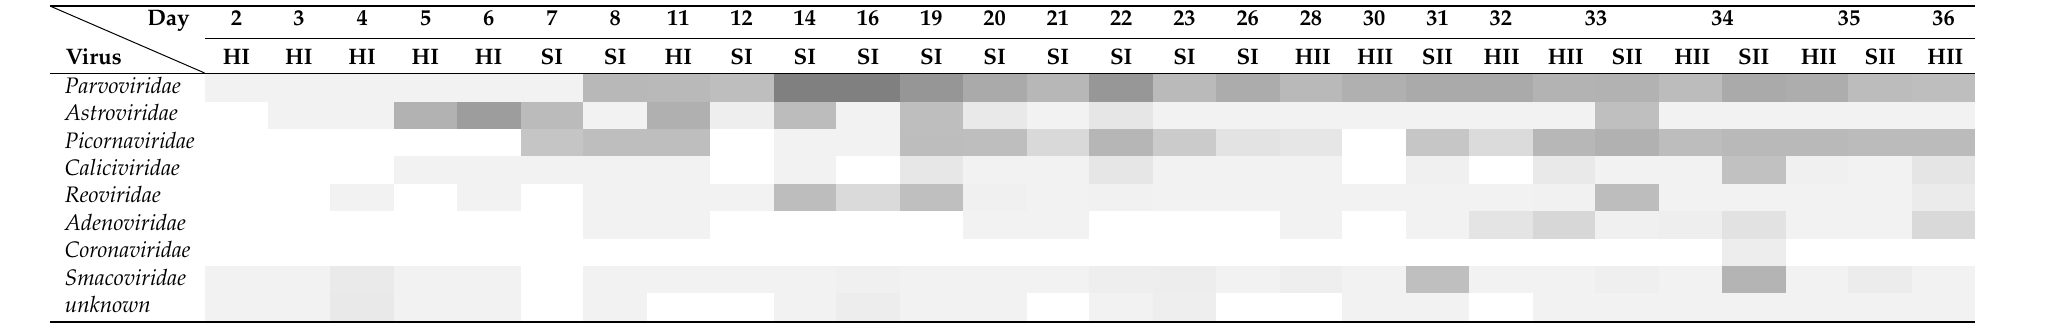
Table 2. Heat map of normalized number of viral family reads detected in samples on different days of production. The following gradient is used: light gray: 15 percentiles of the lowest number; dark gray: 85 percentiles of the highest number of reads; white: viral reads not detected. HI, first sample collection at